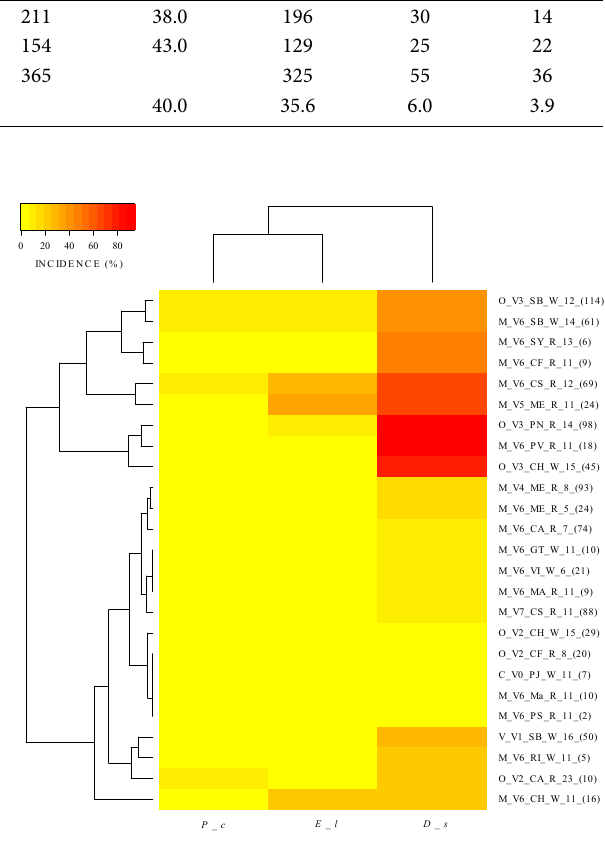
Figure 2. Heatmap with GTDs fungal distribution in the 25